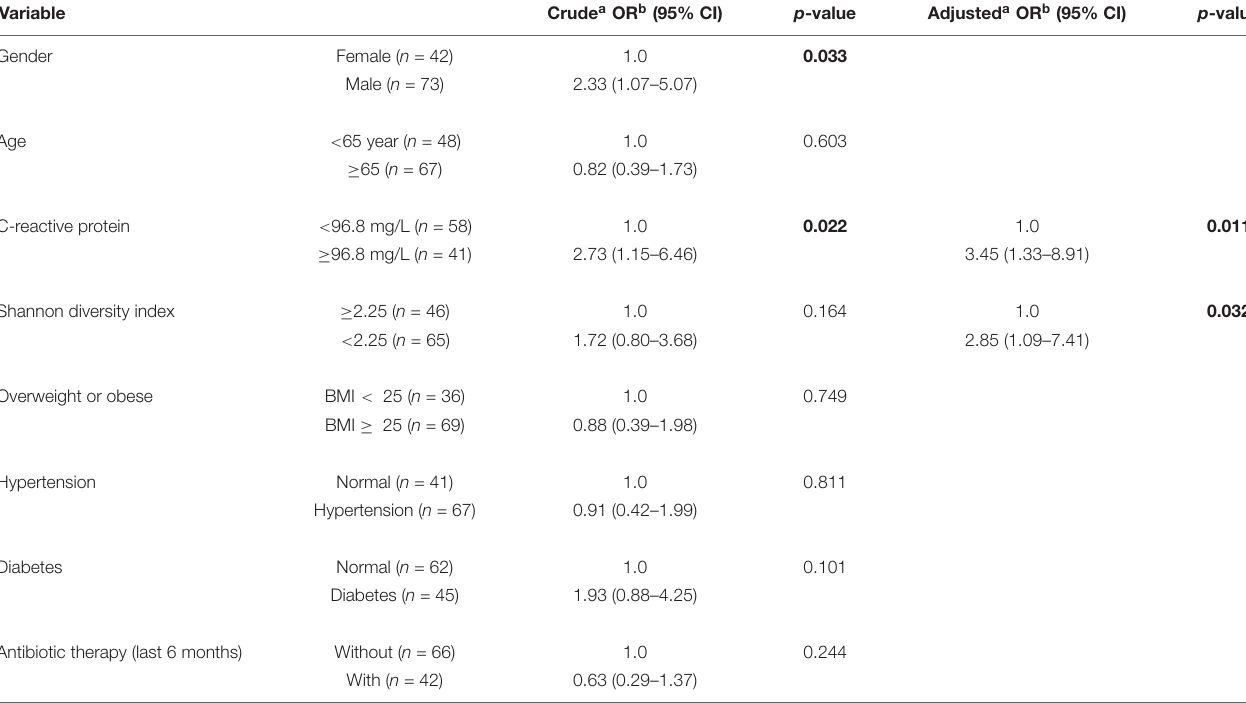
TABLE 2 | Bivariate logistic regression analysis of the clinical variables associated with severity of COVID-19 (a score of 6 or more in the WHO Clinical Progression Scale). Variable Crude a OR b (95%